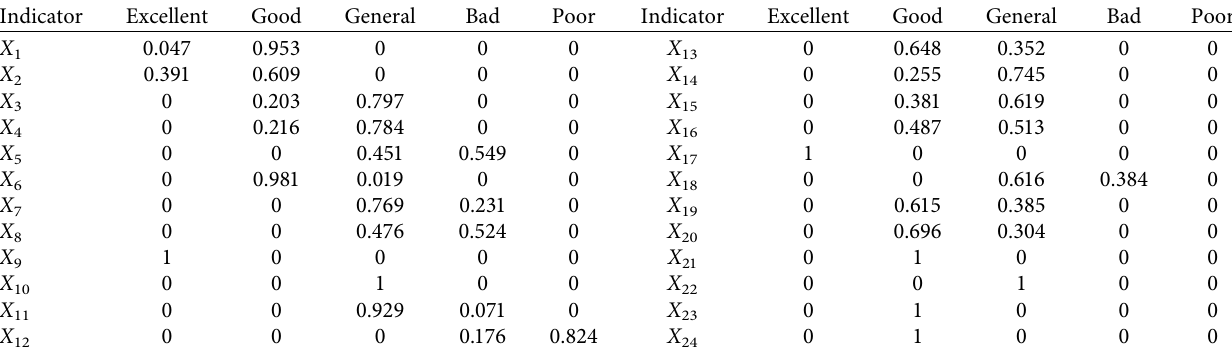
Table 8: The membership degrees of all 24 indicators of platform